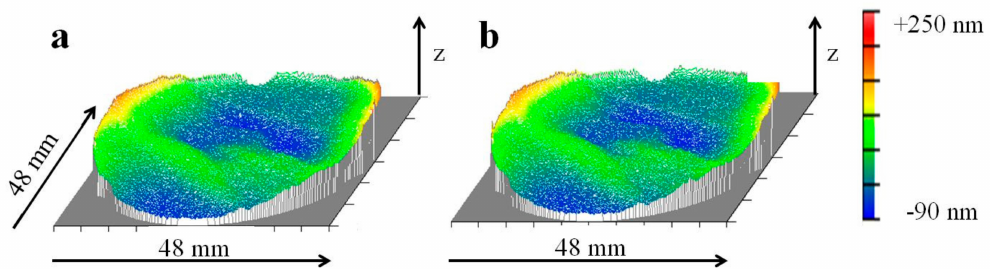
Figure 10. Dimensional stability of a mirror made of Al-42Si; after five cryogenic thermal cycles with 43 nm RMS ( a ); after six cryogenic thermal cycles with 43 nm RMS ( b